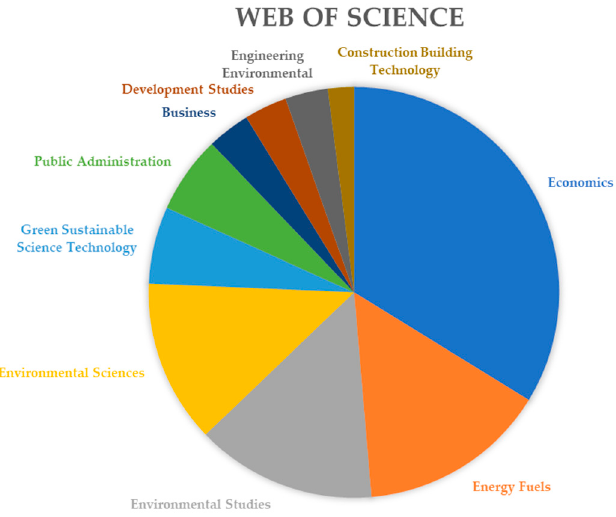
Figure 9. Top 10 subject areas in Web of Science based on articles published annually using second query. Source: Own elaboration.